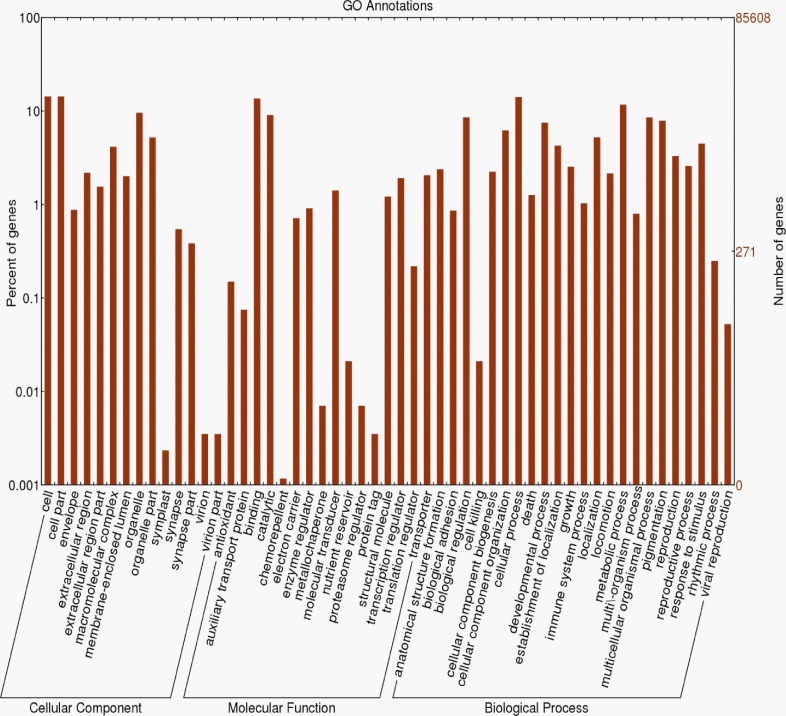
Gene Ontology (GO) Classification of the P. americana Transcriptome.The histogram of the GO annotation was generated automatically using the web histogram tool WEGO (http://wego.genomics.org.cn/cgi-bin/wego/index.pl) based on the most recent GO archive available. The results are summarized into three main GO categories: cellular component, molecular function, and biological process. The right y-axis indicates the number of genes in a category. The left y-axis indicates the percentage of a specific category of genes in that main category. One gene could be annotated into more than one GO term.